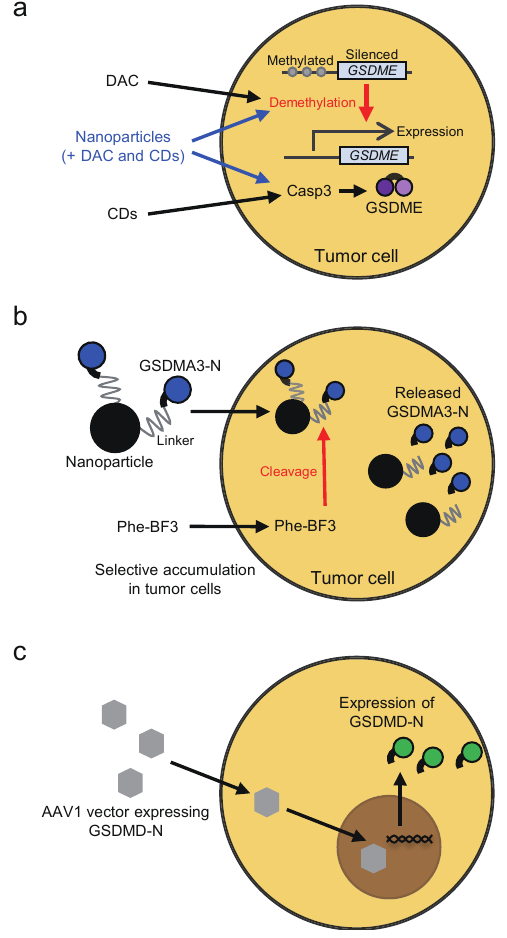
Figure 6. Strategies to induce pyroptosis in tumor cells. ( a ) GSDME expression is silenced in most cancer cells, likely attributed to promoter methylation. Treatment with the DNA methyltransferase inhibitor decitabine (DAC) restores GSDME expression, thereby sensitizing cancer cells to pyroptosis. The combination of decitabine and chemotherapeutic drugs (CDs) can lead to tumor cell pyroptosis via the caspase-3-GSDME pathway. Tumor-targeting nanoparticles loaded with decitabine and chemotherapeutic drugs may be useful to induce pyroptosis in tumors without causing damage in normal tissues. ( b ) A bioorthogonal chemical system has been established to induce tumor cell pyroptosis. In this system, active GSDMA3 protein is conjugated to gold nanoparticles via a silyl ether linker that can be cleaved by desilylation that is catalyzed by phenylalanine trifluoroborate (Phe-BF3), a cancer-imaging probe. Both the nanoparticles and Phe-BF3 selectively accumulate in tumors, enabling controlled release of active GSDMA3 in tumor cells. ( c ) Viral transduction of active forms of GSDMs can also lead to pyroptosis. In a previous study, adeno-associated serotype 1 virus (AAV1)-based vector that expresses GSDMD-N under the control of the schwann-cell-specific promoter P0 was made for the purpose of inducing pyroptosis in